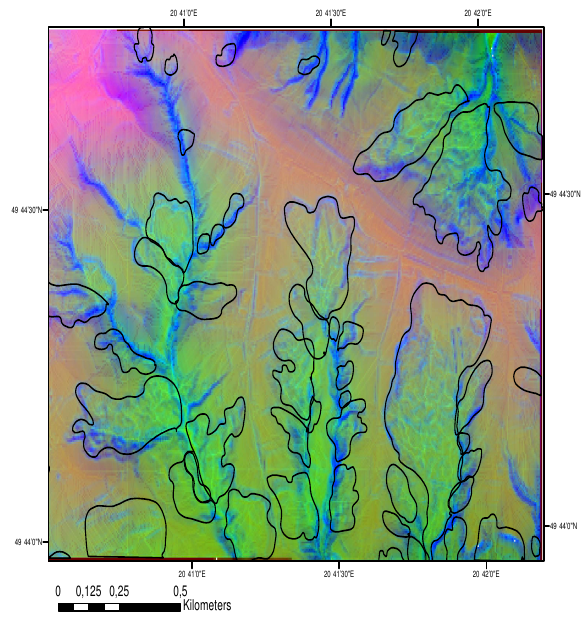
Figure 4: RGB composition of the initial three PCA component with borders (black line) of the existing